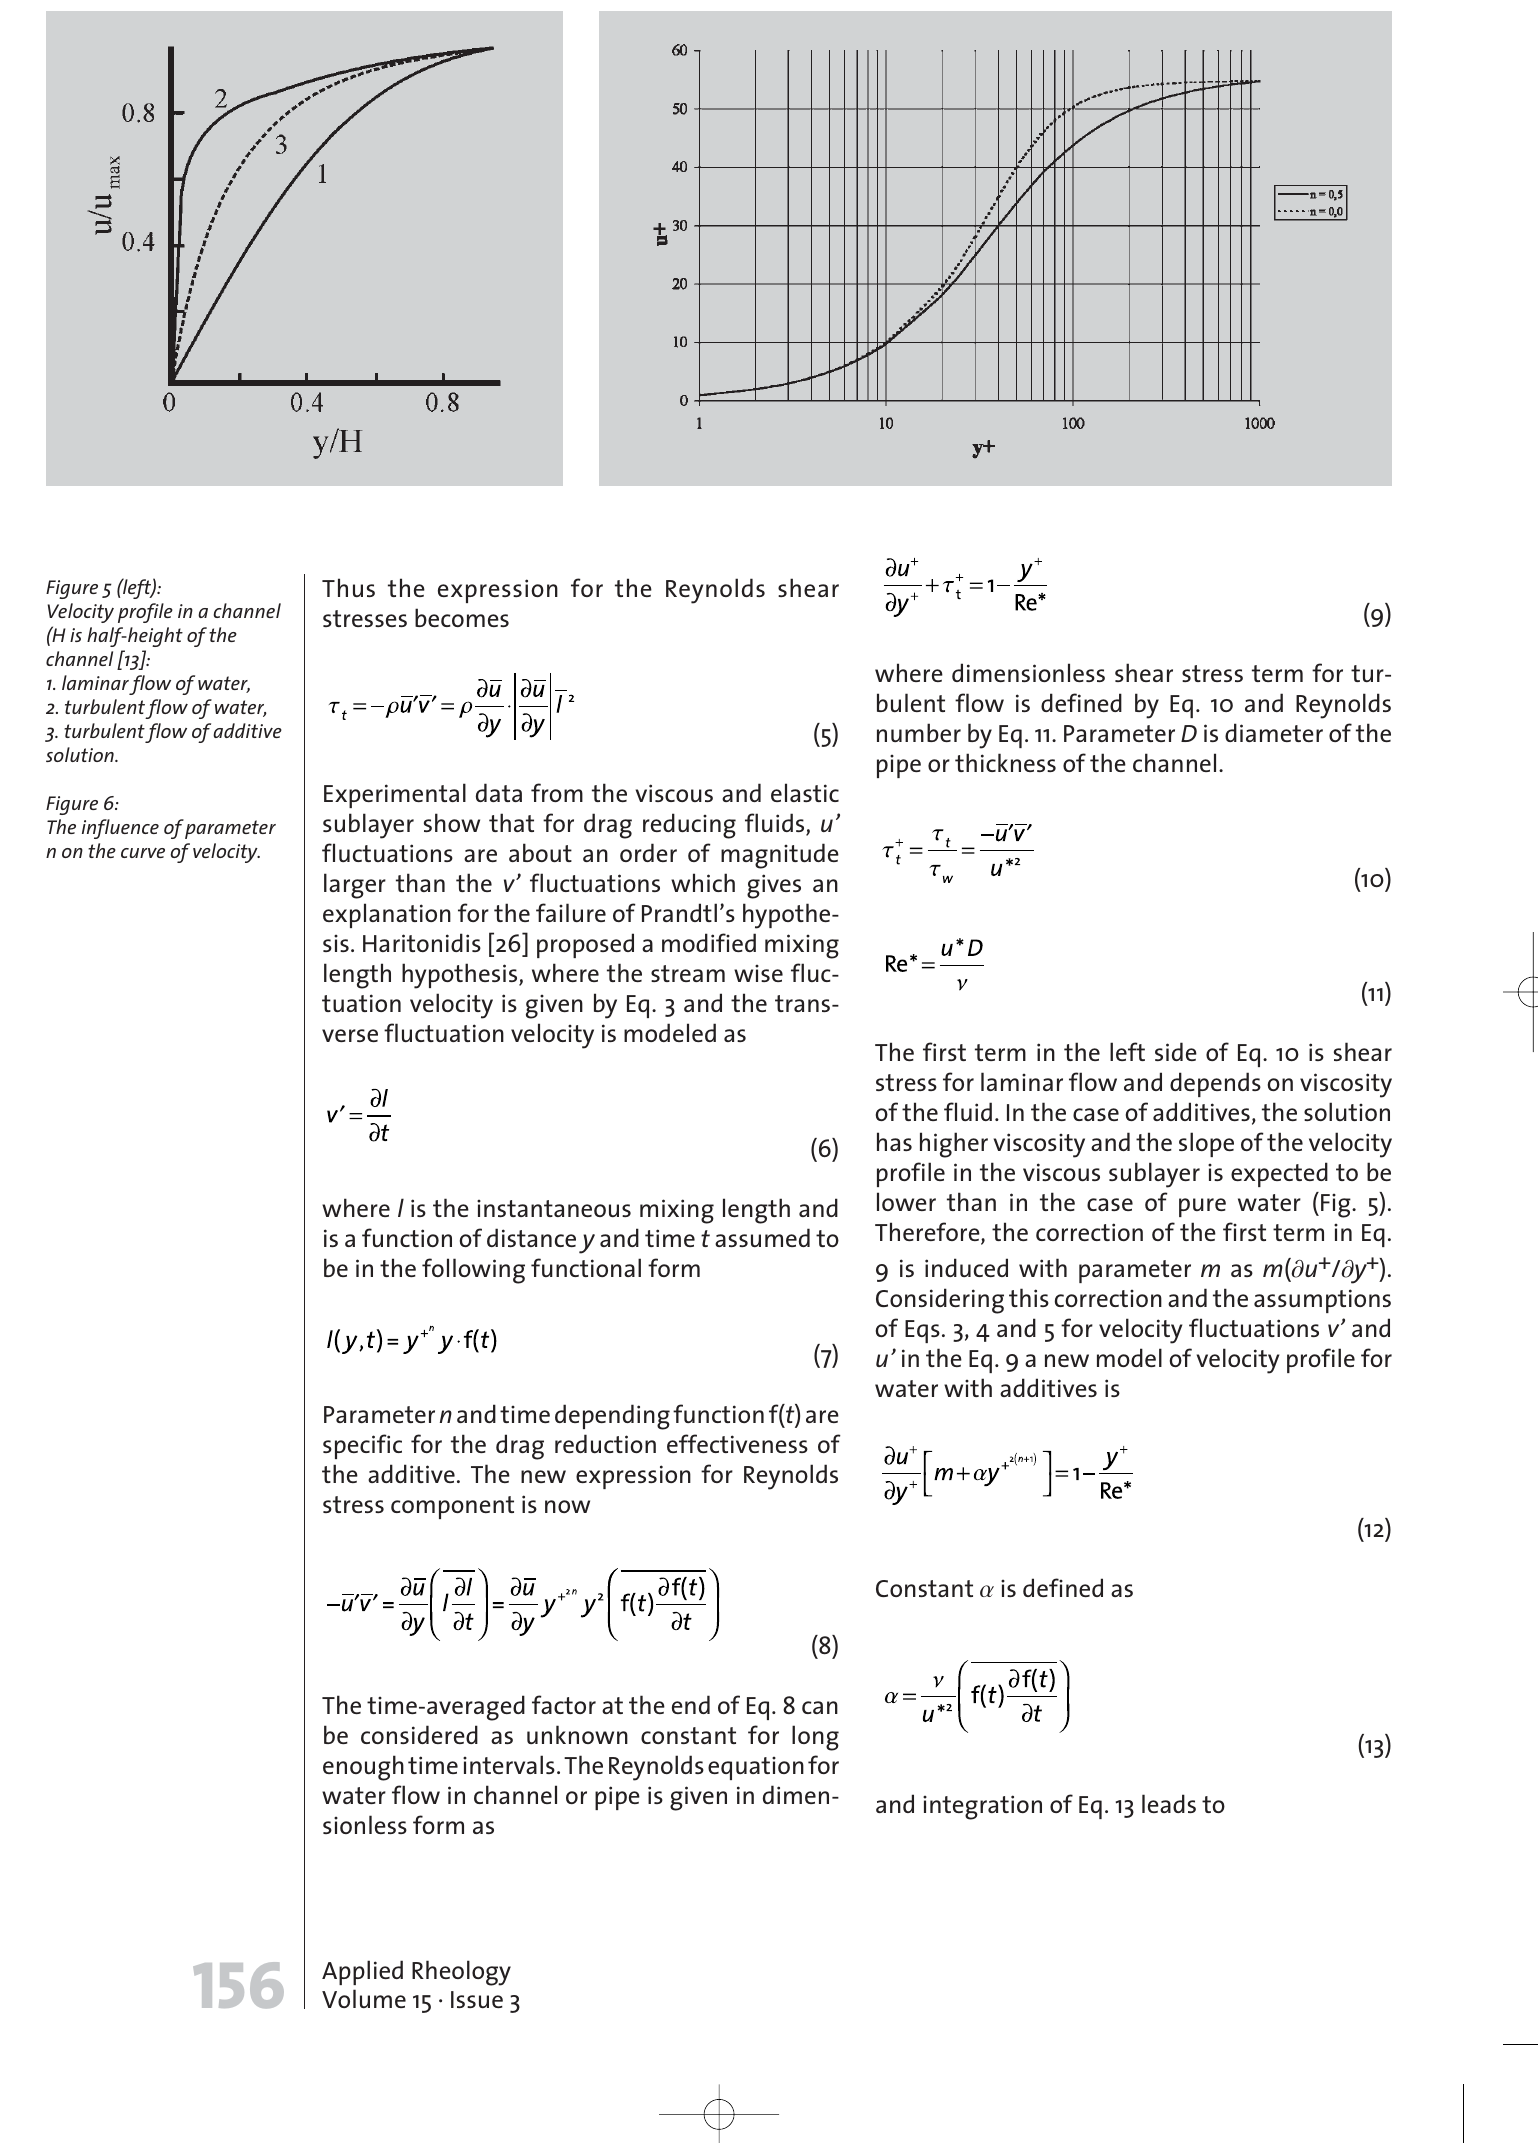
Figure 5 (left): Velocity profile in a channel (H is half-height of the channel [13]: 1. laminar flow of water, 2. turbulent flow of water, 3. turbulent flow of additive solution. Figure 6: The influence of parameter n on the curve of